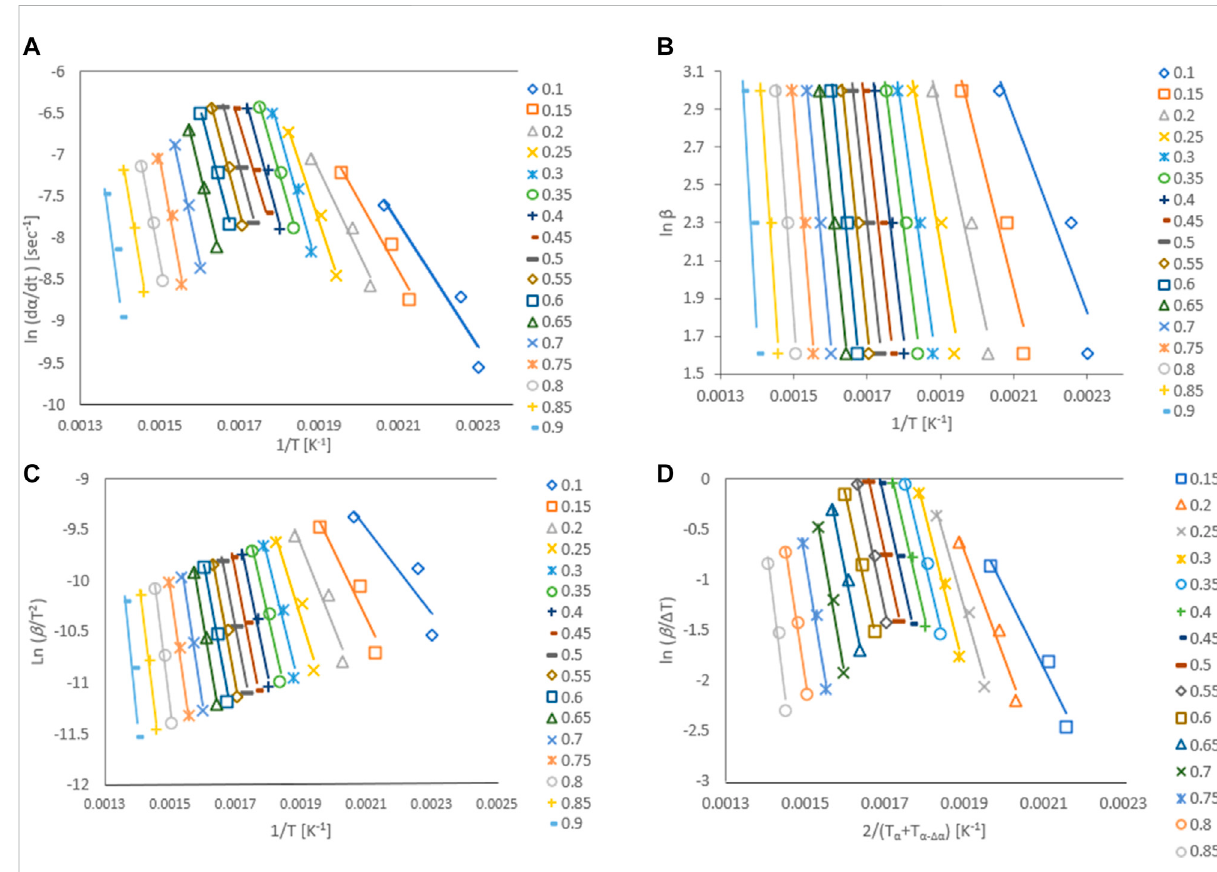
FIGURE 6 Arrhenius plots for G. pectorale at different kinetic models (A) Friedman, (B) Flynn-Wall-Ozawa (FWO), (C) Kissinger-Akahira-Sunose (KAS), and (D) Popescu.